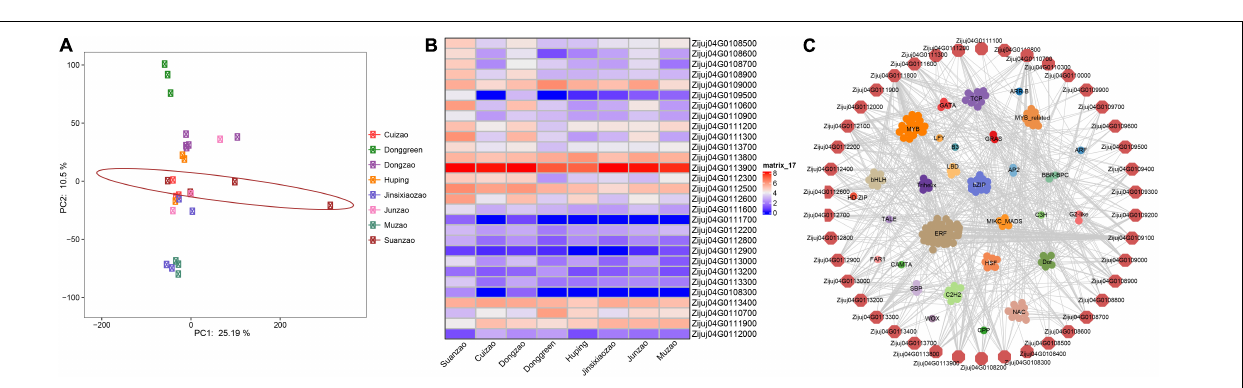
FIGURE 4 | Selection signals with a calculation of composite likelihood ratio (CLR) in three sub-groups. (A) D1; (B) D2; (C) wild; (D) semi-wild.